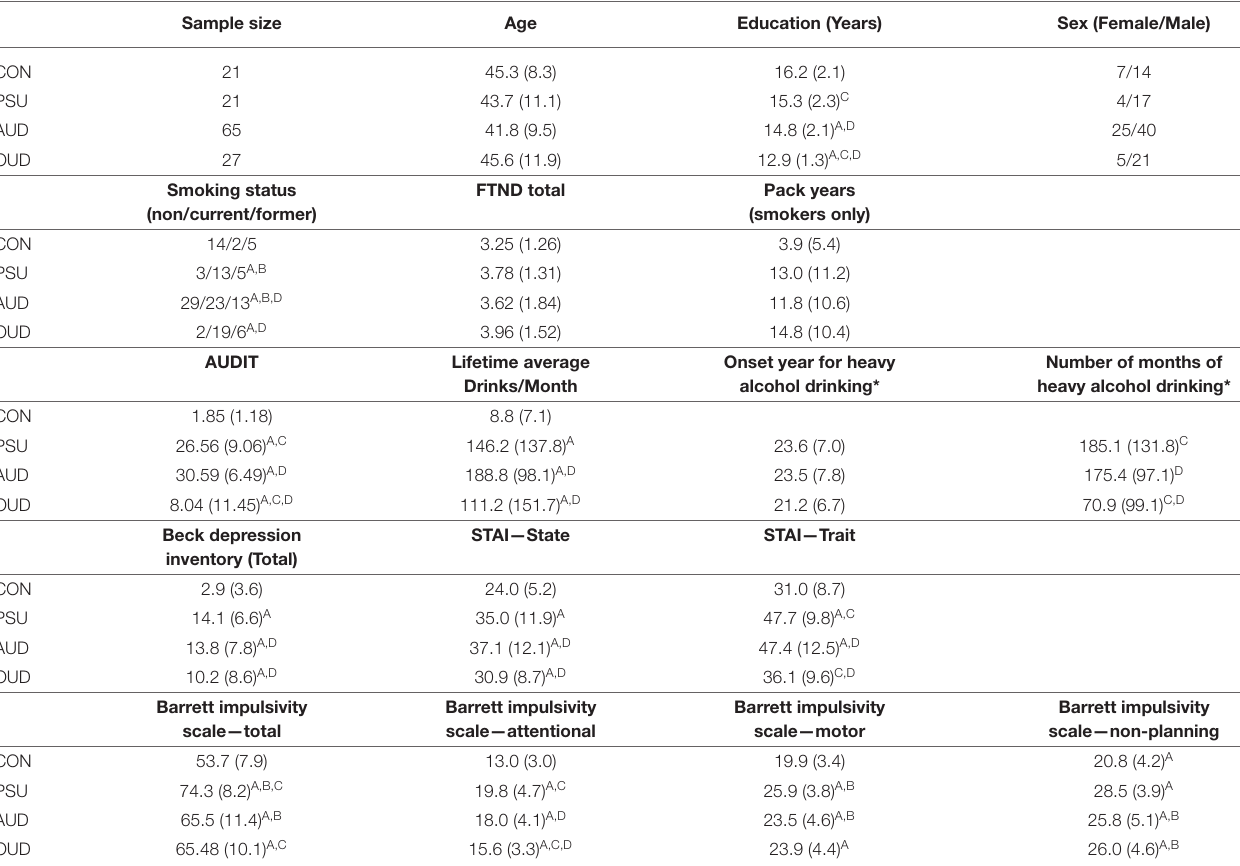
TABLE 1 | Demographics by group, t -tests for group